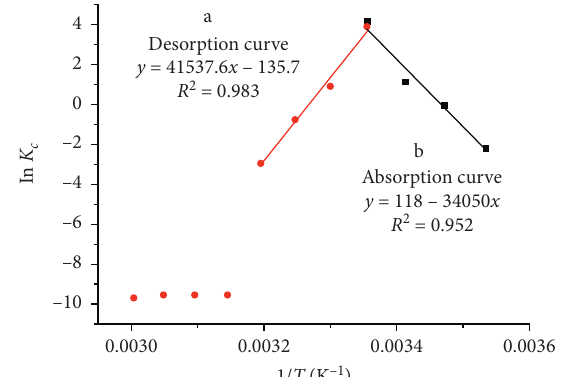
Figure 17: Effect of temperature on adsorption and desorption of Cr(VI) (100ppm in 50 ml) by 0.2 g Fe